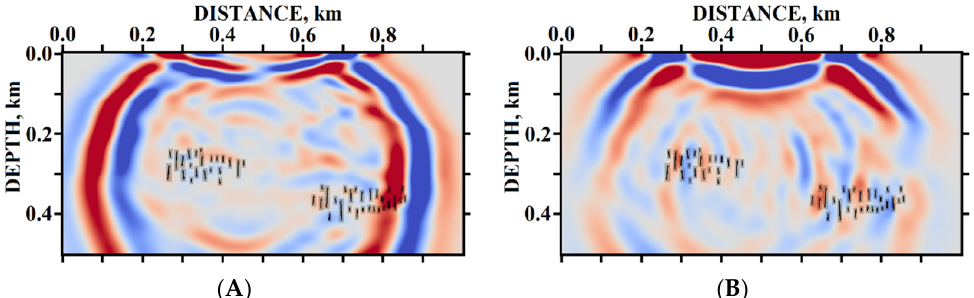
Figure 29. Example #4: ( A ) scales of elastic parameters; ( B ) geophysical model, overlapping curvilinear meshes, the point source is marked by the red dot; ( C ) velocity modulus snapshot.